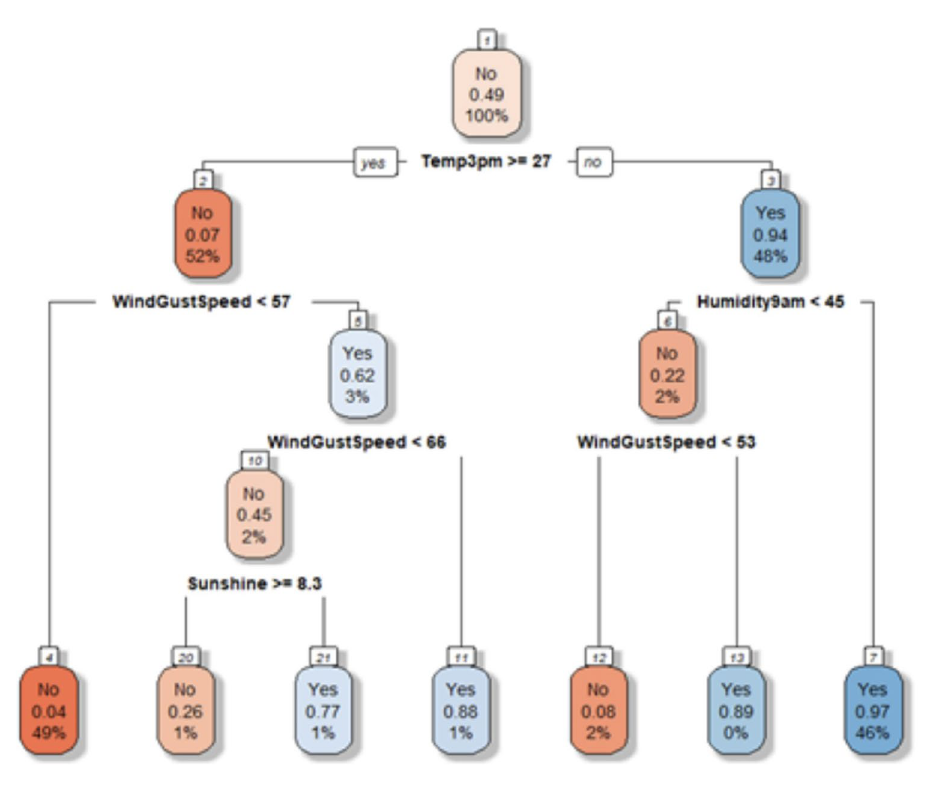
Figure 14. Decision